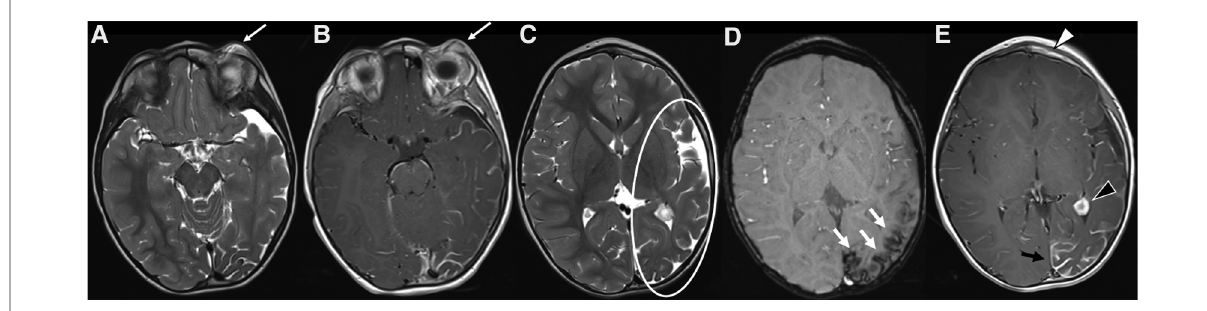
FIGURE 7 MRI of a 3-year-old child with Sturge-Weber syndrome and a capillary malformation (CM) on the left forehead, upper eyelid and periorbital region (V1 distribution). ( A,B ) On the left there is an increased thickness of the periorbital soft tissues (particularly of the skin and subcutaneous tissue) corresponding to the clinically visible mark, which shows a subtle hyperintensity on axial T2-weighted sequence and a faint but rather homogeneous enhancement on axial post contrast T1 weighted sequences (white arrows in A and B, respectively). ( C – E ) Typical associated intracranial features of SWS on the same side (left) of the CM, including atrophy of the cerebral hemisphere with enlargement of subarachnoid spaces (especially in the frontal, insular, parietal and occipital regions, white circle in C ), cortical gyral hypointensities due to calci fi cations on SWI (white arrow in D ), contrast enhancement of the leptomeningeal angioma and choroidal plexus hypertrophy on axial post-Gadolinium T1 weighted sequence (black arrow and arrowhead in E , respectively). A subtle enhancement of the left frontal bone is also evident (white arrowhead in E ), due to the intra-osseus extension of the overlying